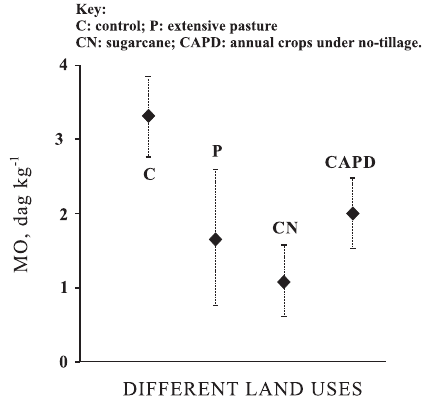
Figure 1. Mean values and confidence interval (95 %) for organic matter (OM), calculated for the 0– 20 cm soil layer in areas of different land